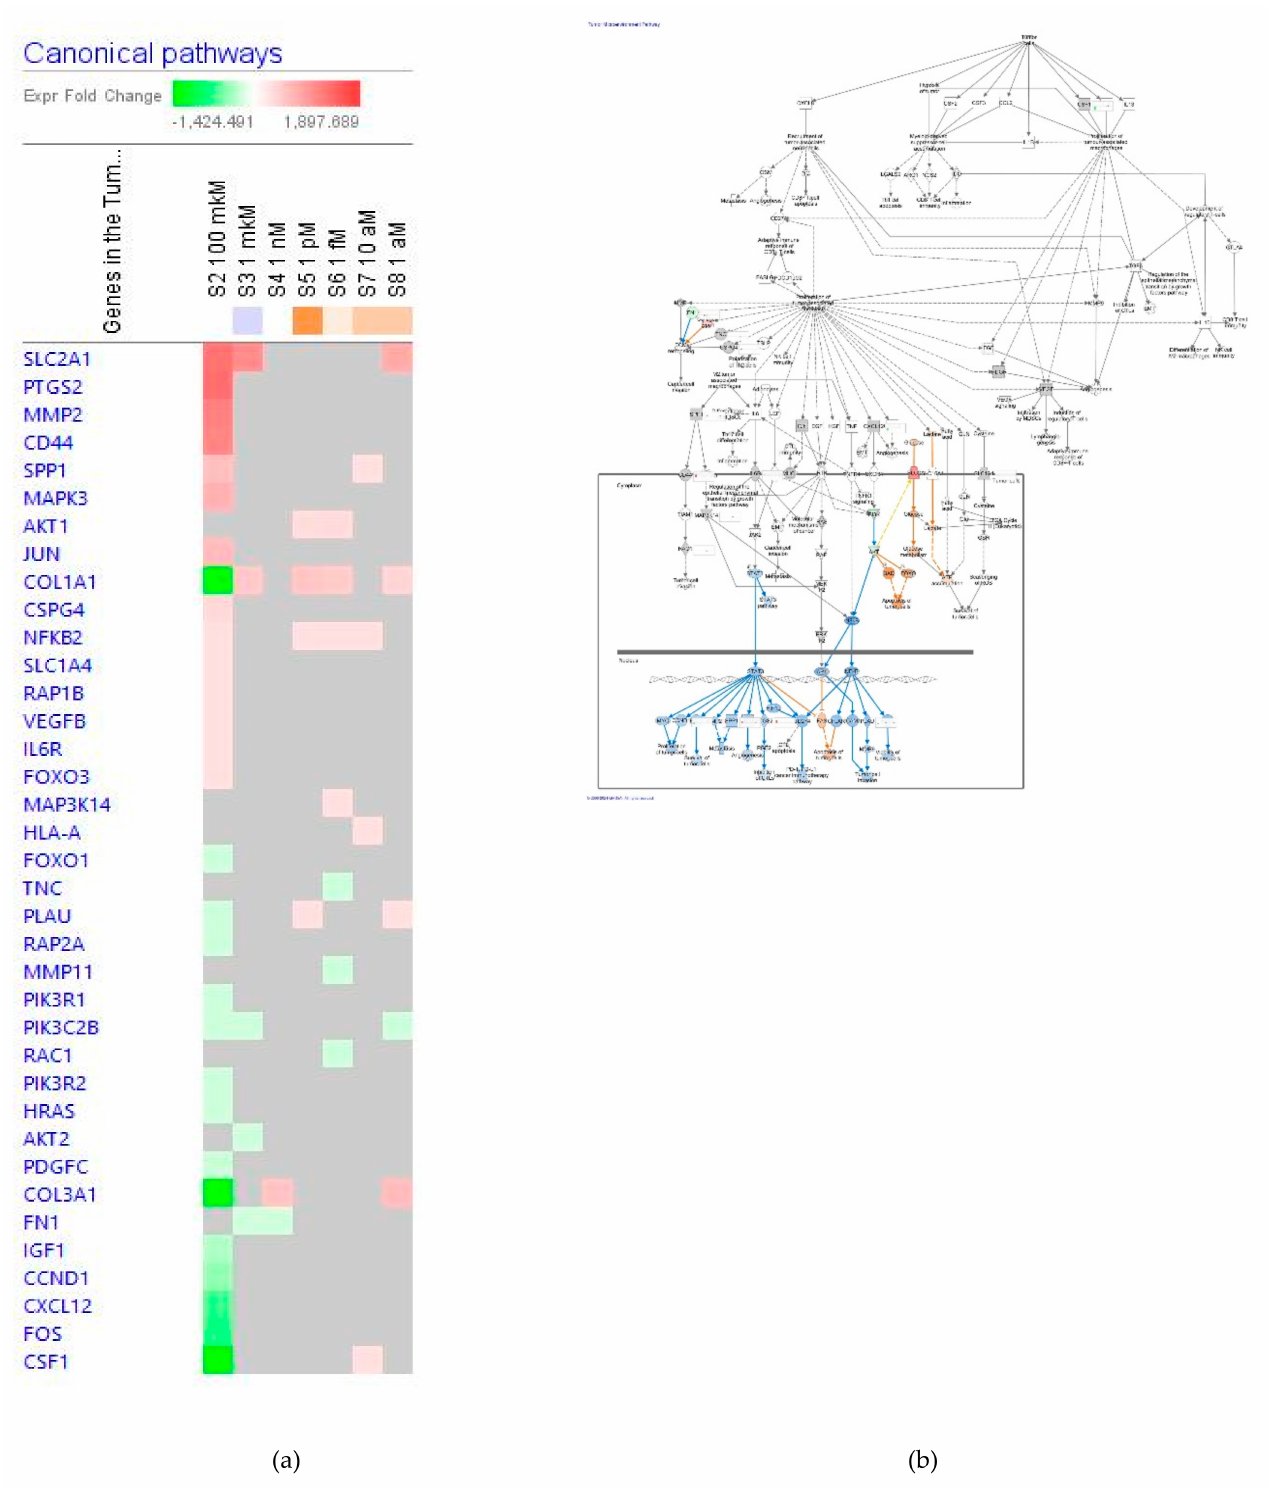
Figure 13. Effect of Rg5 on tumor microenvironment signaling pathway: ( a ) Heatmap of gene expression (in fold changes compared to control, red, upregulation and green, downregulation), after exposure with ginsenoside Rg5 in different concentrations; the 100 mM signature is shown in the leftmost column as solid red or green squares indicating genes that are upregulated or downregulated, respectively; color intensity indicates the actual log-fold changes; ( b ) Rg5 at a concentration of 1 µ M—predicted inhibition (blue) and activation